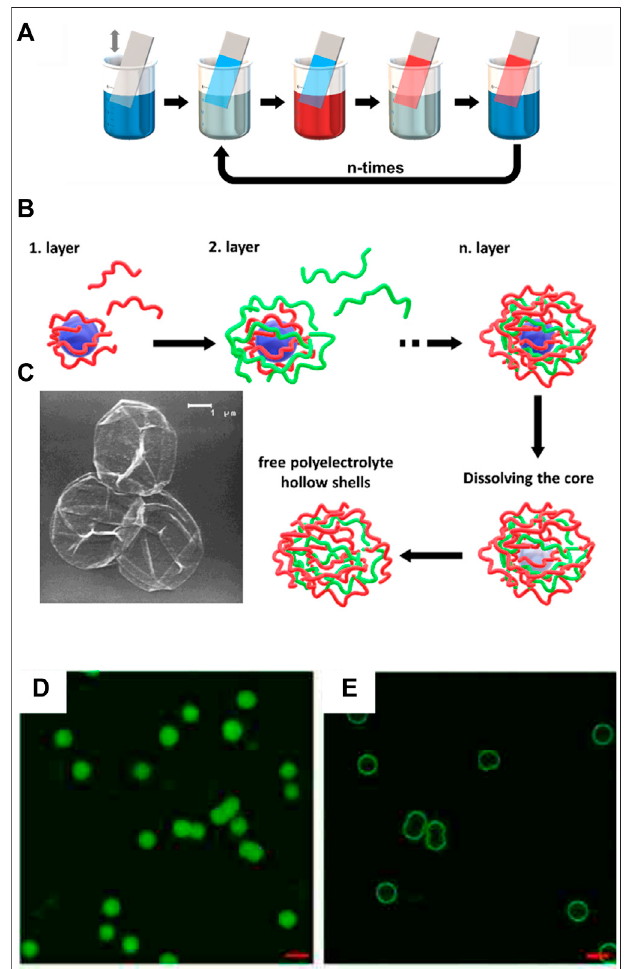
FIGURE1| Polyelectrolytemultilayers: (A) Schemeofthe fi lmdeposition processusingslidesandbeakers.Steps1and3representtheadsorptionofa polyanion and polycation, respectively, and steps 2 and 4 are washing steps forthebasicbuildupsequence(A/B) n . (B) Capsuleformation:Schematic illustration of the polyelectrolyte deposition onto a particle process and of subsequent core decomposition; (C) SEM of nine-layer [(poly (styrene sulfonate)/poly (allylamine hydrochloride) 4 /poly (styrene sulfonate)] capsules. Drying, together with the topological constraints of the closed surface, results in a completely folded upper hemisphere (Donath et al., 1998). (D,E) Poly (styrenesulfonate)/poly (N, N-dimethylaminoethylmethacrylate) capsules with encapsulation of fl uorescein isothiocyanate: (D) at pH (cid:1) 9 and (E) release at pH (cid:1) 7;Scalebar 5 μ m(Xuet al.,2014).Reprinted withpermission. Copyright © 1998 WILEY-VCH Verlag GmbH, Weinheim, Fed. Rep. of